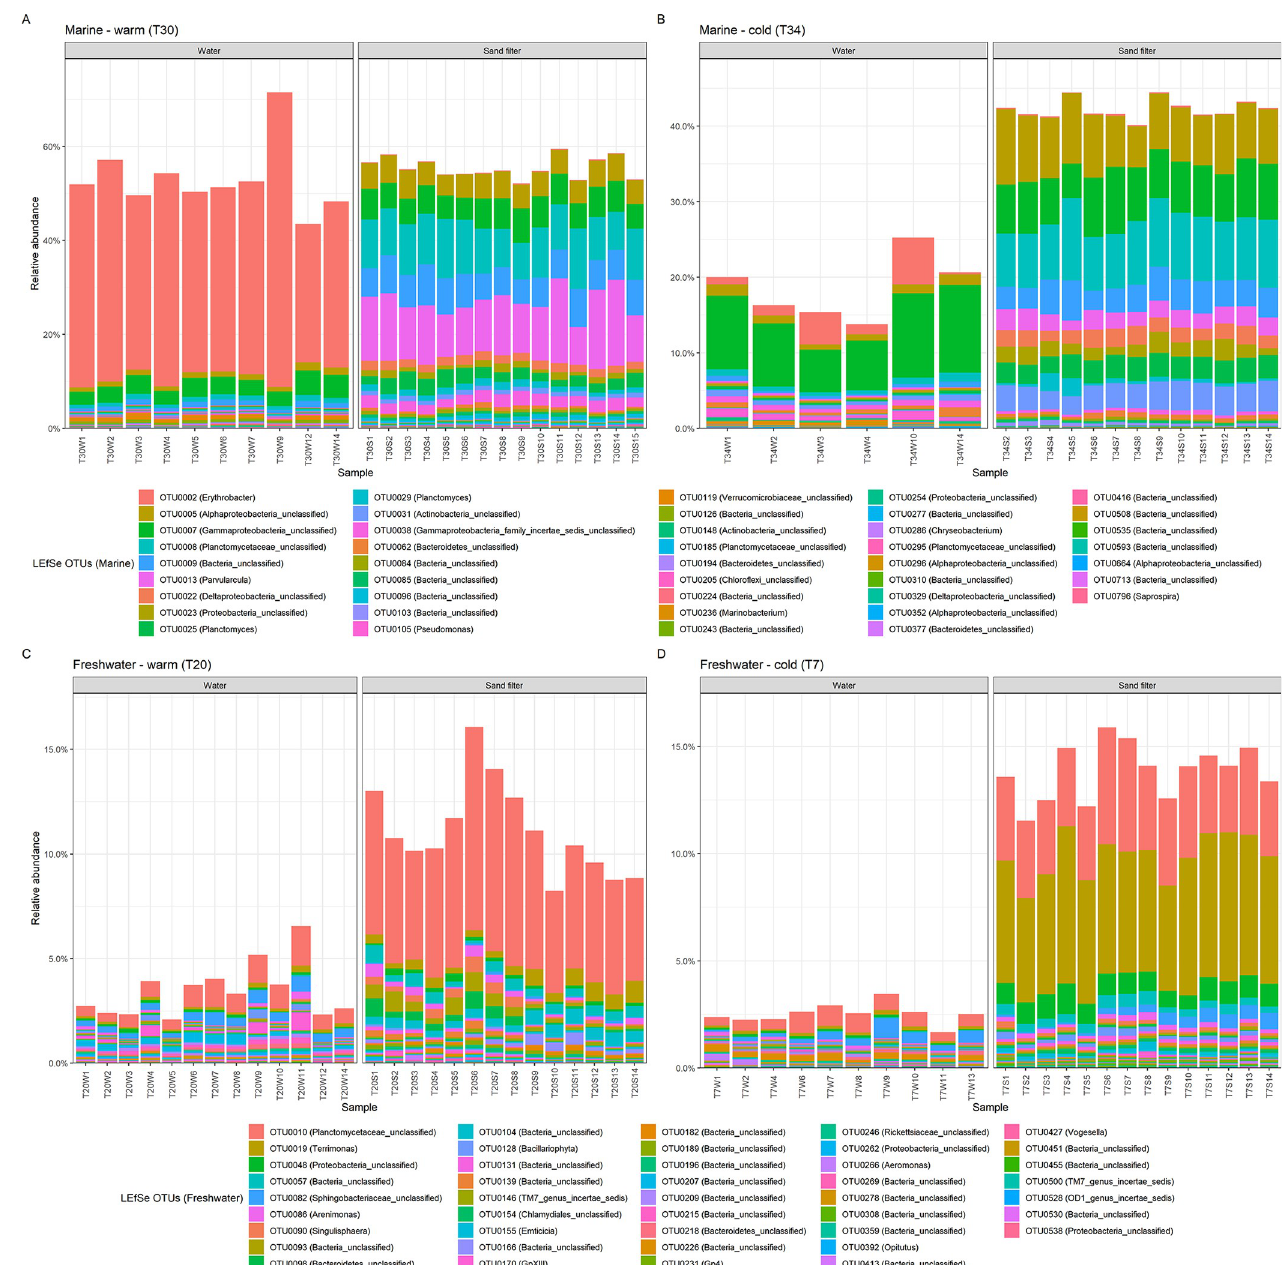
Fig 3. Relative abundance of biomarker OTUs in each habitat over time. Biomarker OTUs were determined by linear discriminant analysis for marine (A, B) and freshwater (C, D) tanks. See S5 Table for taxonomic identification of OTUs.